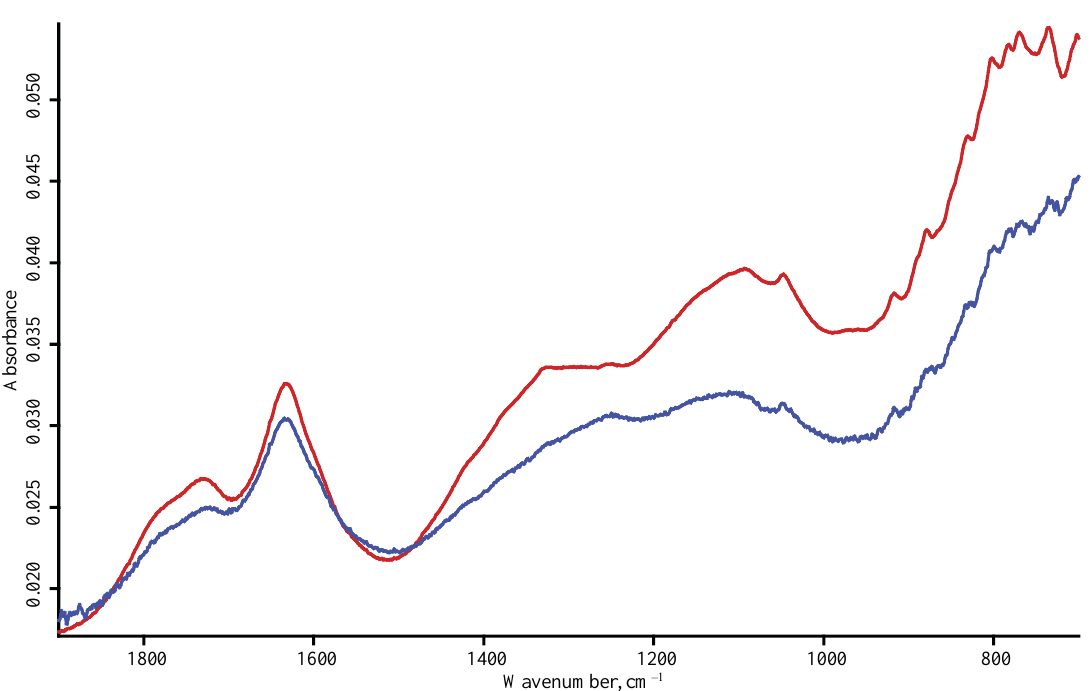
Figure A5. ATR mode, PL-Nanopure-G01P nanodiamonds; red, LN-MCT photovoltaic detector; blue, DLaTGS detector. Spectra are not smoothed but normalized to maximize each spectrum.